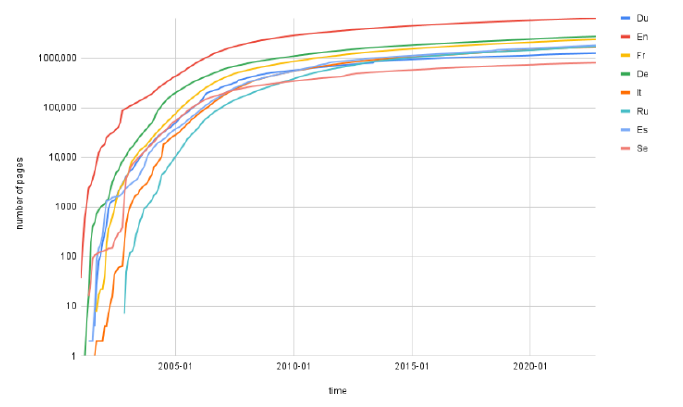
Figure 9. Logarithmic trend of the growth of pages created by users of some of the biggest Wikipedia editions. Codes: Du = Dutch, En = English,Fr = French, De = German, It = Italian, Ru = Russian, Es = Spanish, Se = Swedish. Data collected from [33].